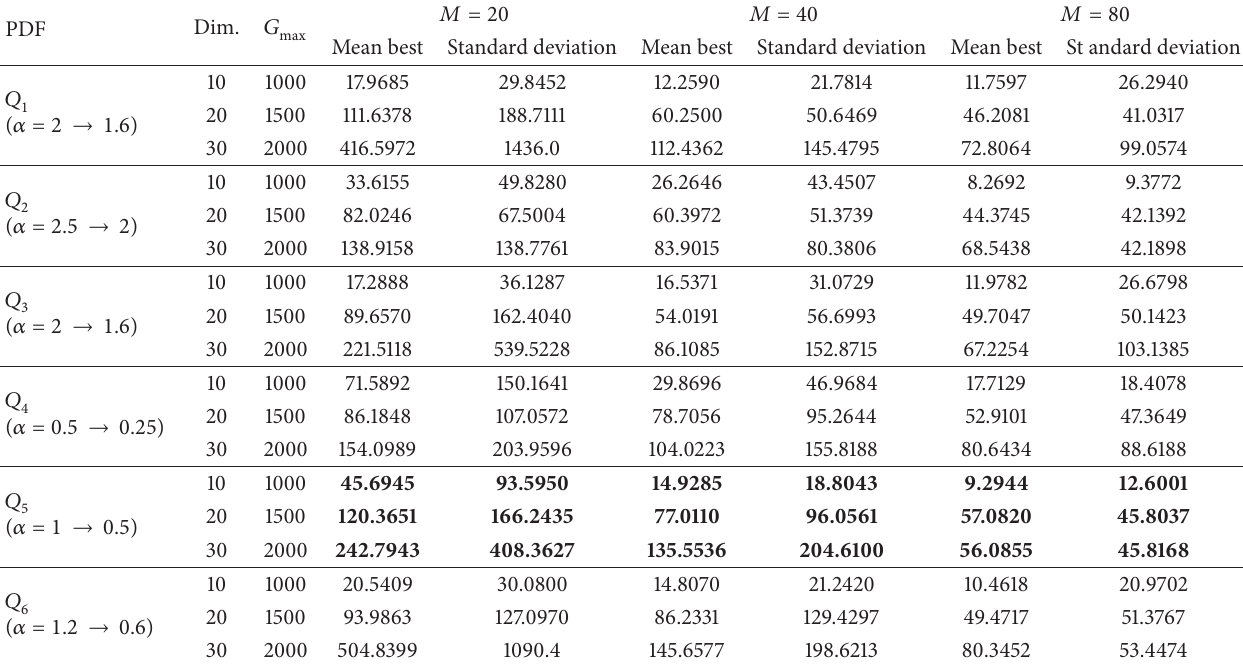
Table 3: Mean best fitness values and standard deviation for the Rosenbrock function. PDF